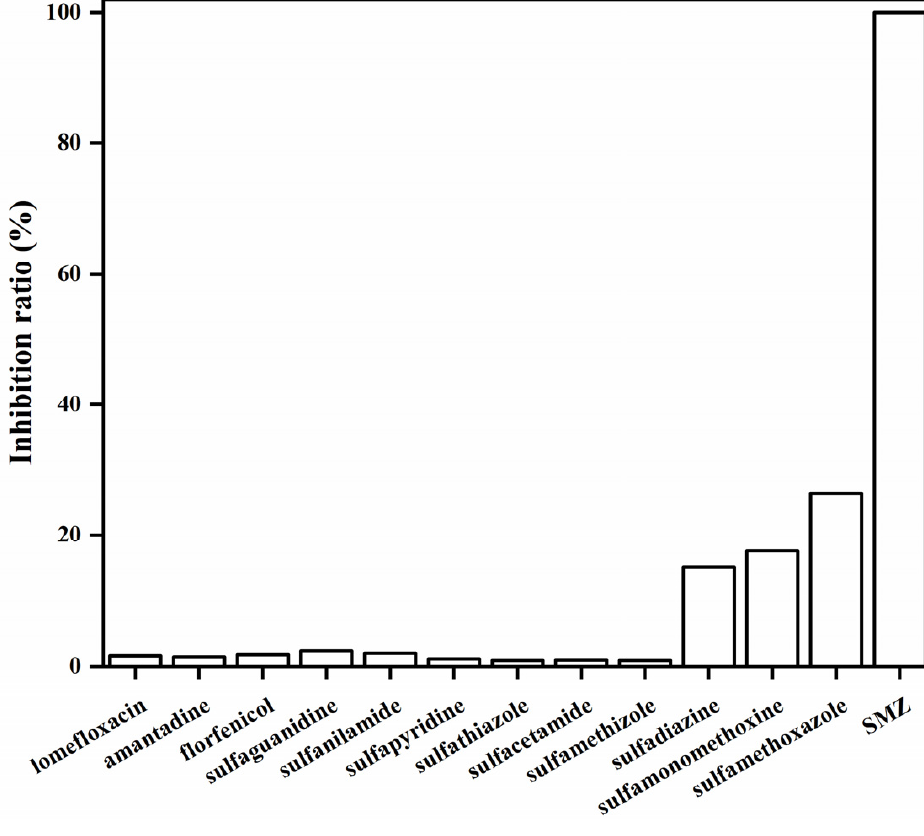
Figure 9. The specificity of QBs-LFIA was tested at a concentration of 20.0 ng/mL with structurally similar analogs.